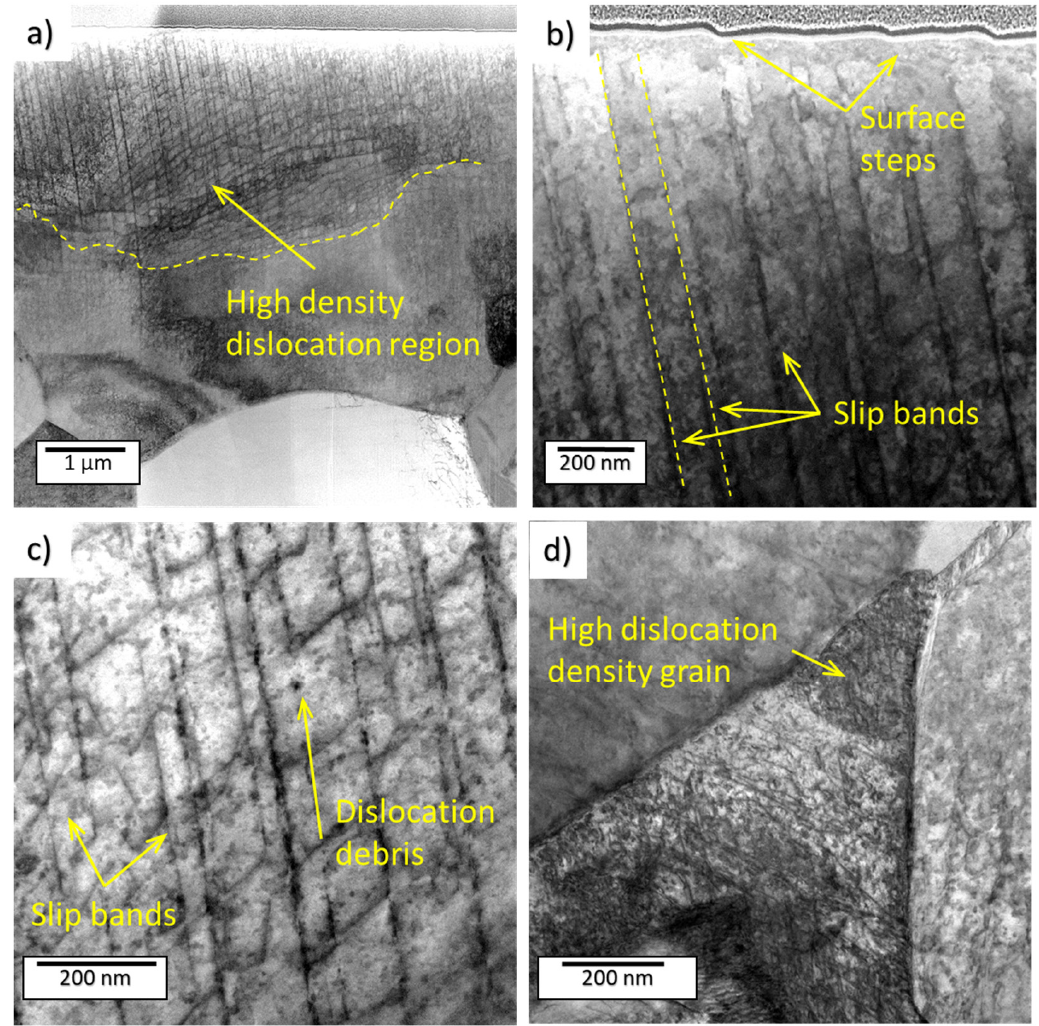
Figure 10. Micrographs of Ti6Al4V treated with 52,500 impacts. Scanning transmission electron imaging (STEM) in bright field (BF) mode. ( a ) Pt layer is seen at the upper part of the micrograph. High dislocation density just below the surface is clearly seen. ( b ) Surface steps correlates with slip bands in the interior of the grain.( c ) Slip bands and dislocation debris in the interior of the grain.( d ) Dense dislocations net in a suitably oriented